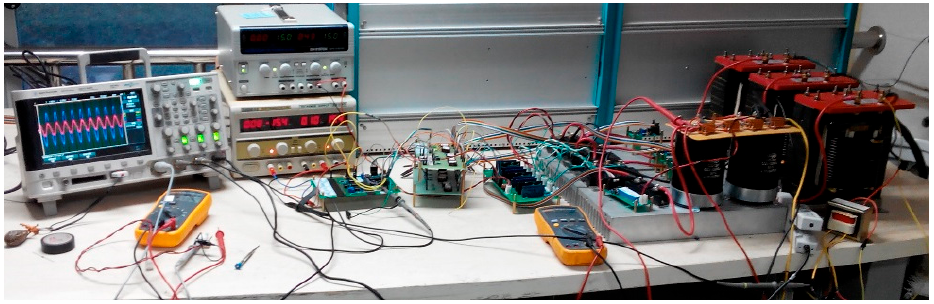
Figure 12. Input phase current and phase voltage.